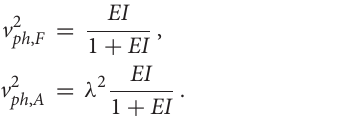
FIGURE 1 | Cut-off frequencies and resonance frequencies ordering for given µ , as function of E . The right panel is a zoom on the behavior near E horizontal logarithmic scale for E -values in the left (weakly magnetized plasma), vs. a linear scale in the right panel (strongly magnetized). The upper and lower cut-offs ω 2 u , l are plotted as gray solid lines (the ω 2 c 1 is the middle horizontal line). The vertical dashed gray lines indicate the special values E = For each E value, the three colored (purple, blue and red) curve pairs indicate resonance ranges, where parallel propagation corresponds to the solid line, and perpendicular to the dashed line. The red range reaches its perpendicular limit at zero frequency, hence no dashed red line